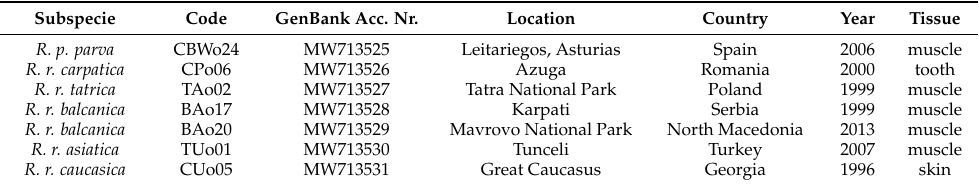
Table 1. Information about the origin and GenBank accession numbers of the seven newly sequenced samples.